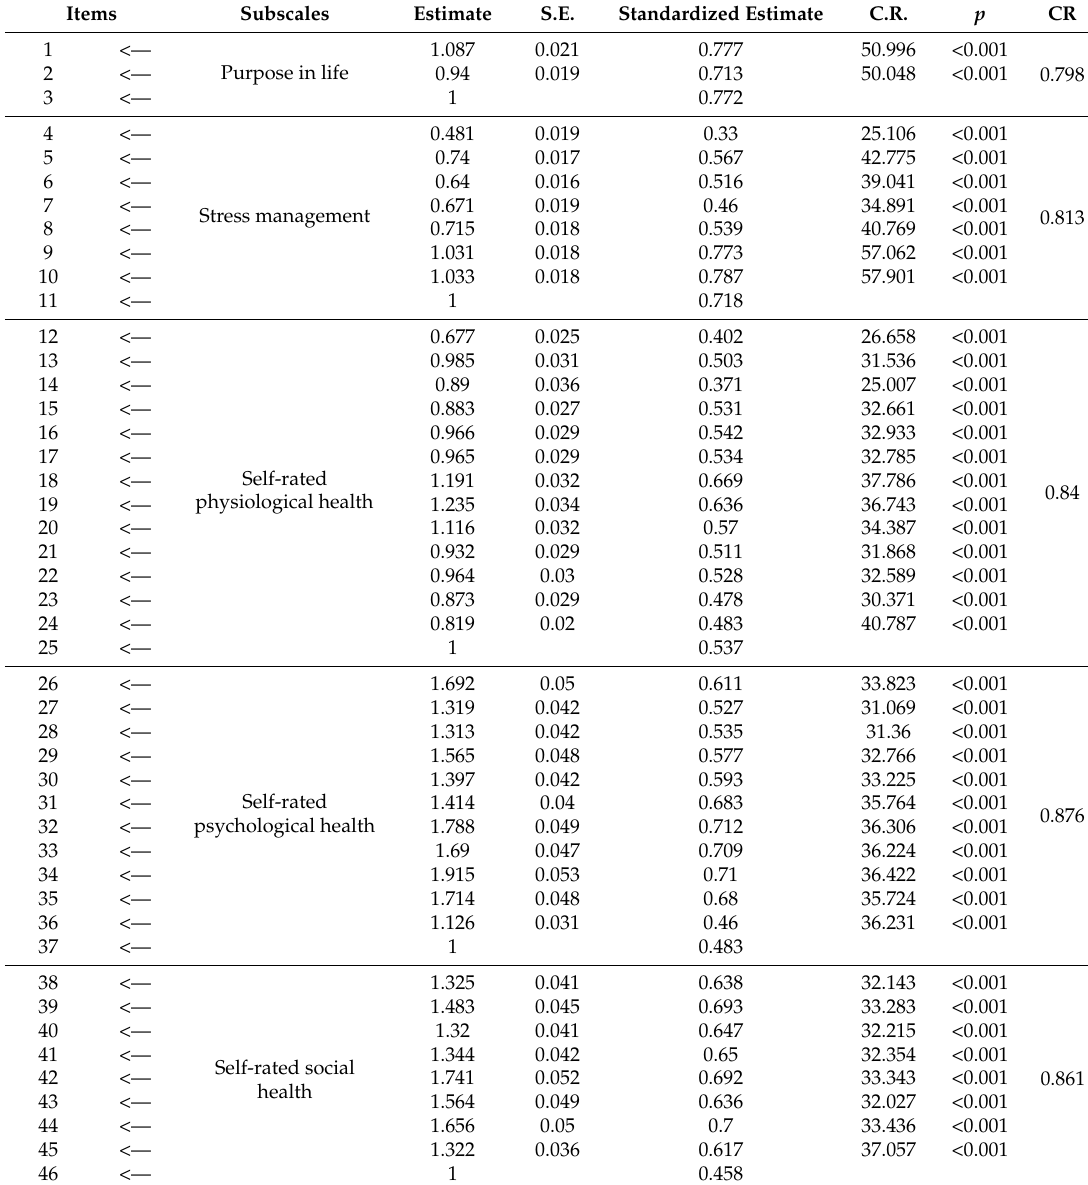
Table 3. The confirmatory factor analysis of the